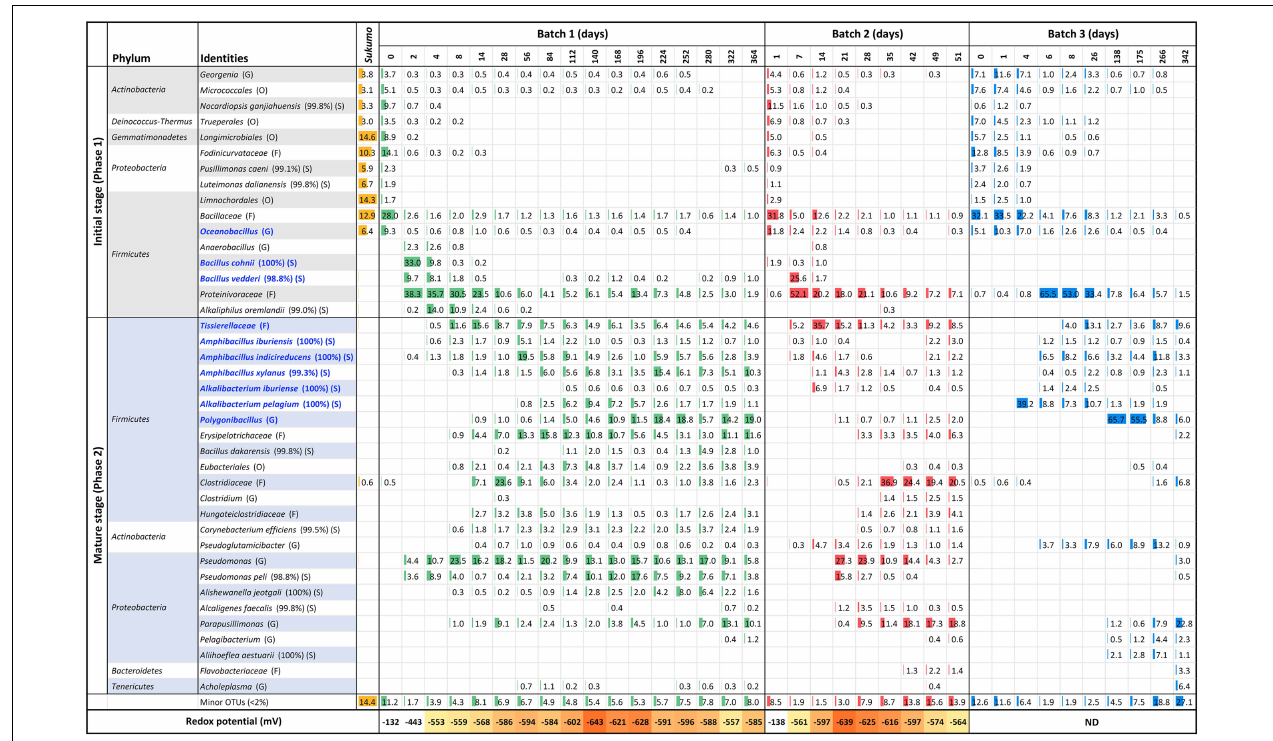
FIGURE 1 | Changes in the relative abundance of bacterial communities ( ≥ 2% in any sample) and redox potential, depending on the fermentation age in indigo fermentation fluid Batch 1, 2, and 3, based on 16S rRNA analysis. Blue letters indicate the confirmed indigo-reducing taxa (including unpublished results). The percentages in the brackets indicate the similarities with the known species in the database. Classification hierarchy depends on database similarity as follows: O, order level ( < 90% similarity); F, family level ( ≥ 90, < 95%); G, genus level ( ≥ 95, < 98.6%); and S, species level ( ≥ 98.6). ND, no